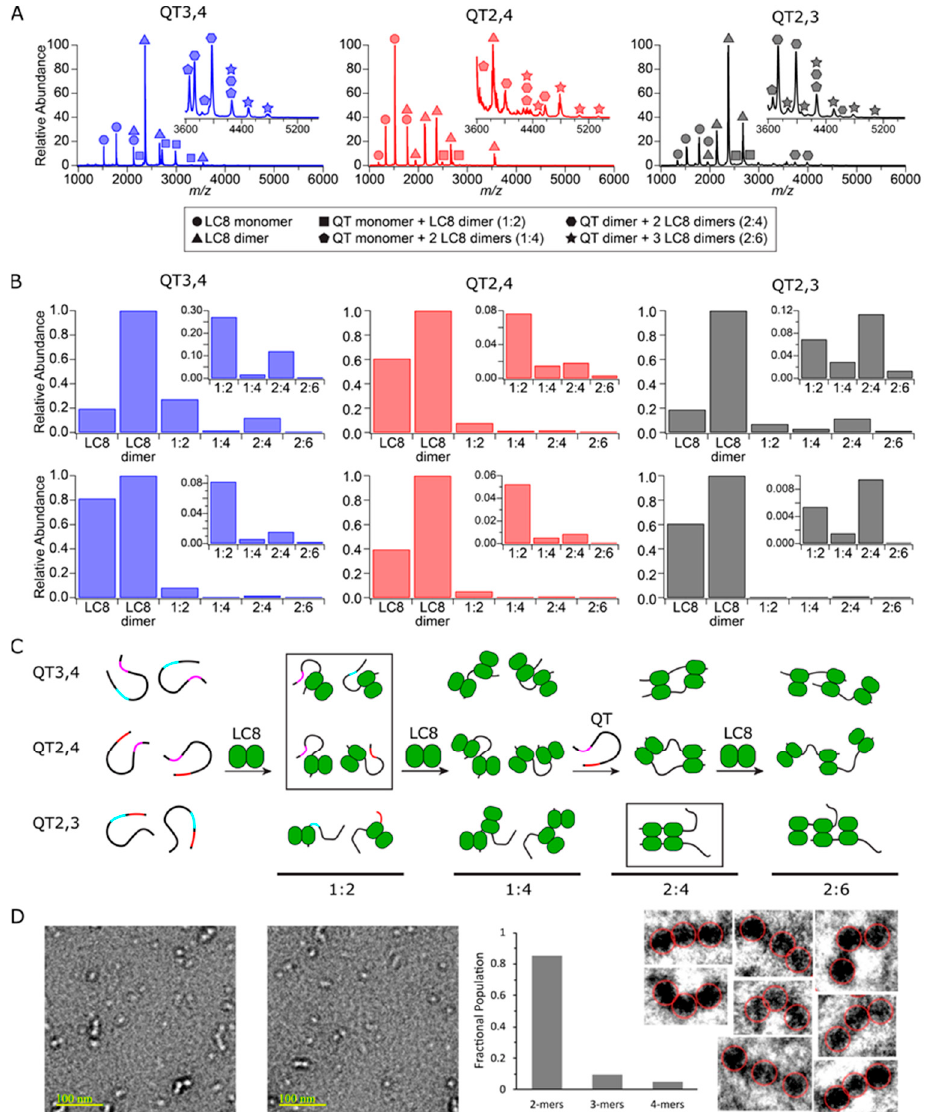
Figure 5. QT/LC8 complex species and abundance distributions determined by ESI-MS and EM. ( A ) Native mass spectra of double-site variants at 25 µM are shown with individual and complex species labeled. ( B ) Abundance distributions of species detected at 25 µM ( top ) and 5 µM ( bottom ) for each double-site variant are shown. ( C ) Monomeric chains of each double site variant with QT2, QT3, and QT4 sites color coded. Upon addition of LC8, 1:2, 1:4, 2:4, and 2:6 complexes form. The most abundant complex species for each QT construct is boxed. ( D ) Two representative EM images out of 50 captured of QT2–4/LC8 mixture in which bright dots in the images indicate LC8 dimers. Plotted relative populations of complexes seen in EM, and zoomed negatives of all eight 3-mers observed in the 50 images.